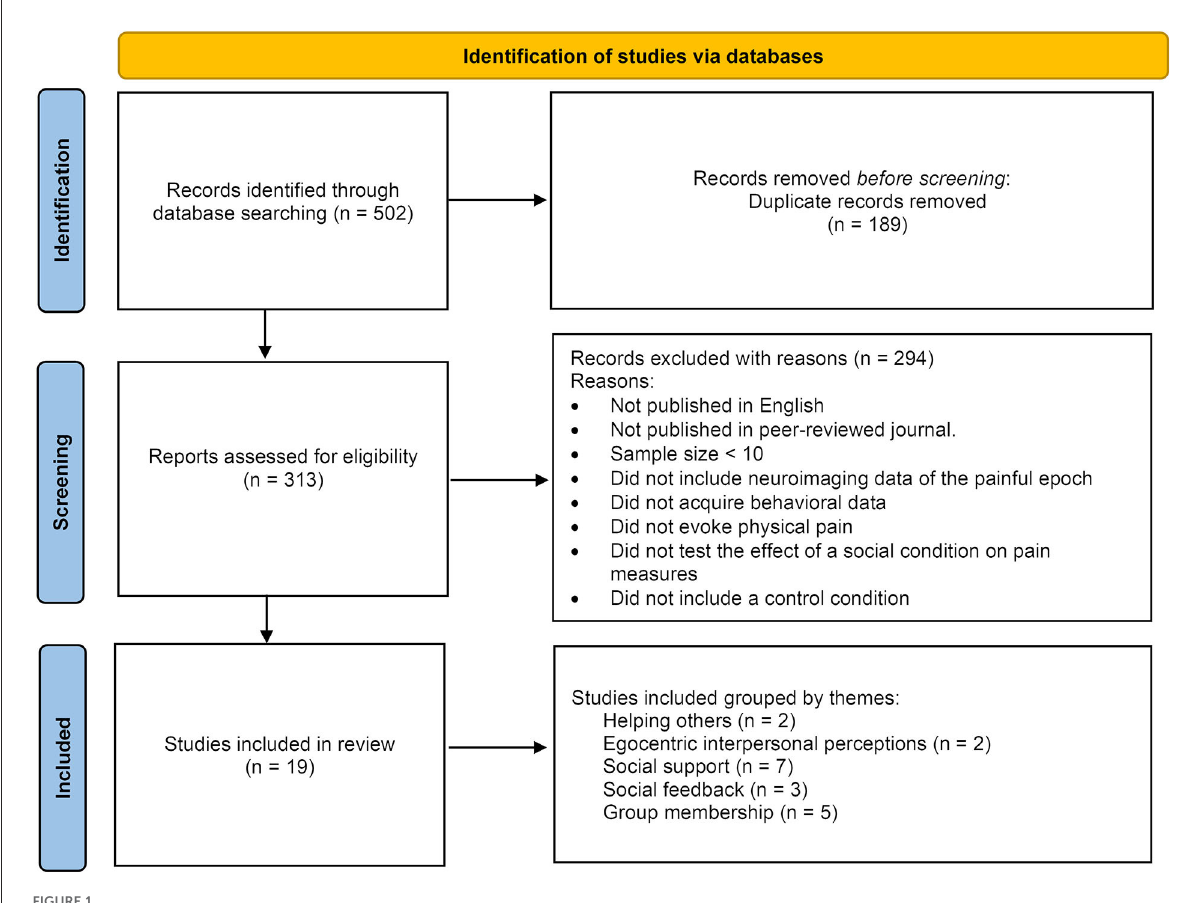
FIGURE1 Summary of the study selection